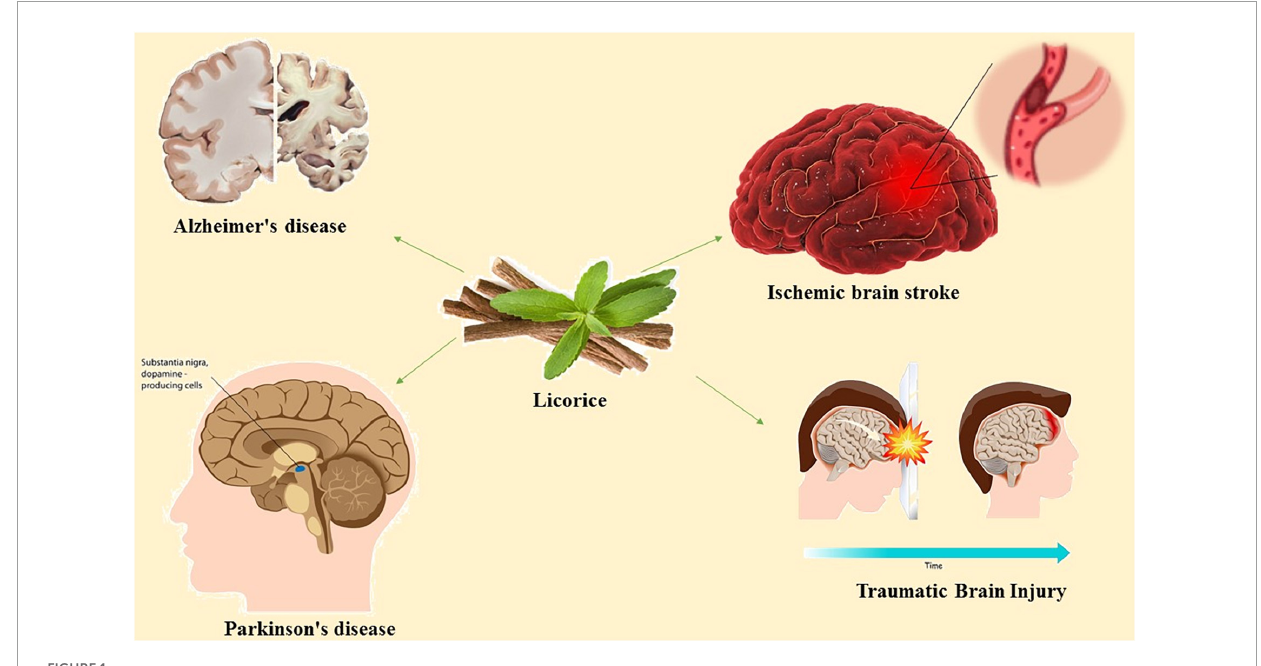
FIGURE1 Schematic illustration of the effects of licorice on neural disorders.